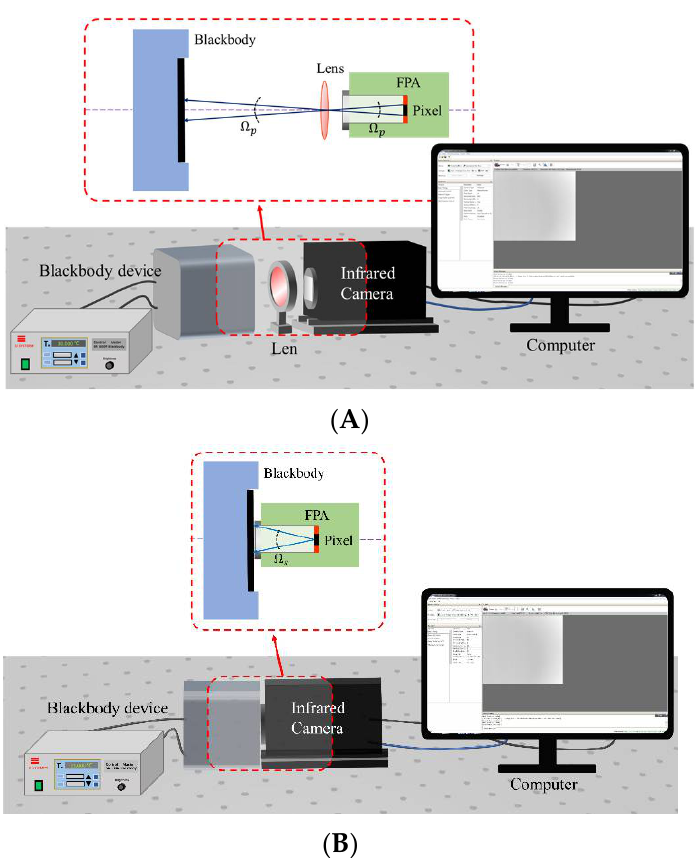
Figure 4. ( A ) Schematic diagram of the device for the calibration of the whole infrared system; geometric optical distribution of the infrared radiation at the detector pixel when observing the external blackbody. ( B ) Schematic of detector calibration based on blackbody baffle; geometric optical distribution of infrared radiation at the pixel.